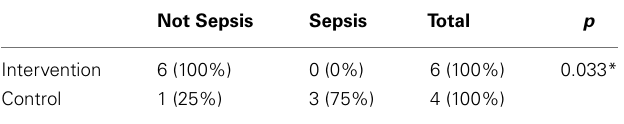
Table 4 | BSI in infants without previous infection